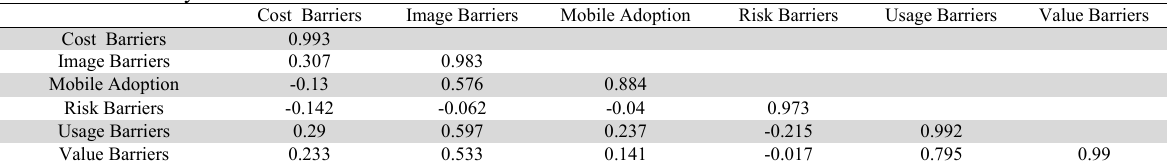
Discriminant validity